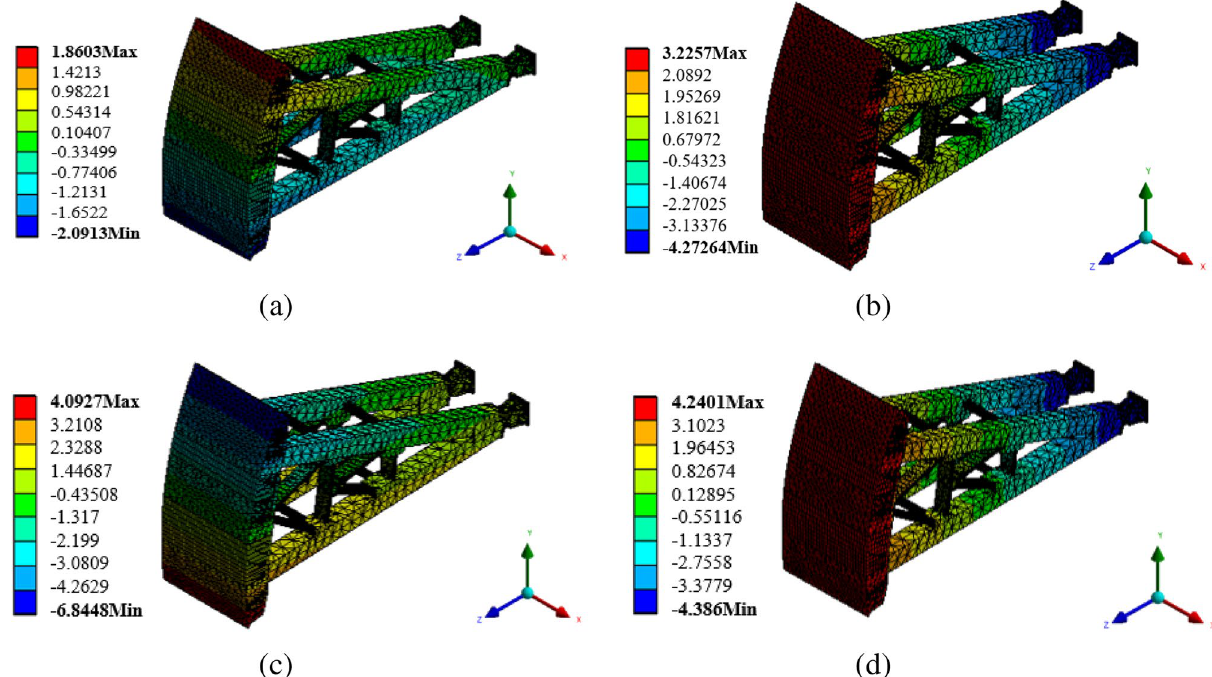
Figure 8. Nephogram of structural displacement response of calculation model. ( a ) Nephogram of displacement response in X direction, ( b ) Nephogram of displacement response in Y direction, ( c ) Nephogram of displacement response in Z direction, and ( d ) Nephogram of total displacement response (unit: